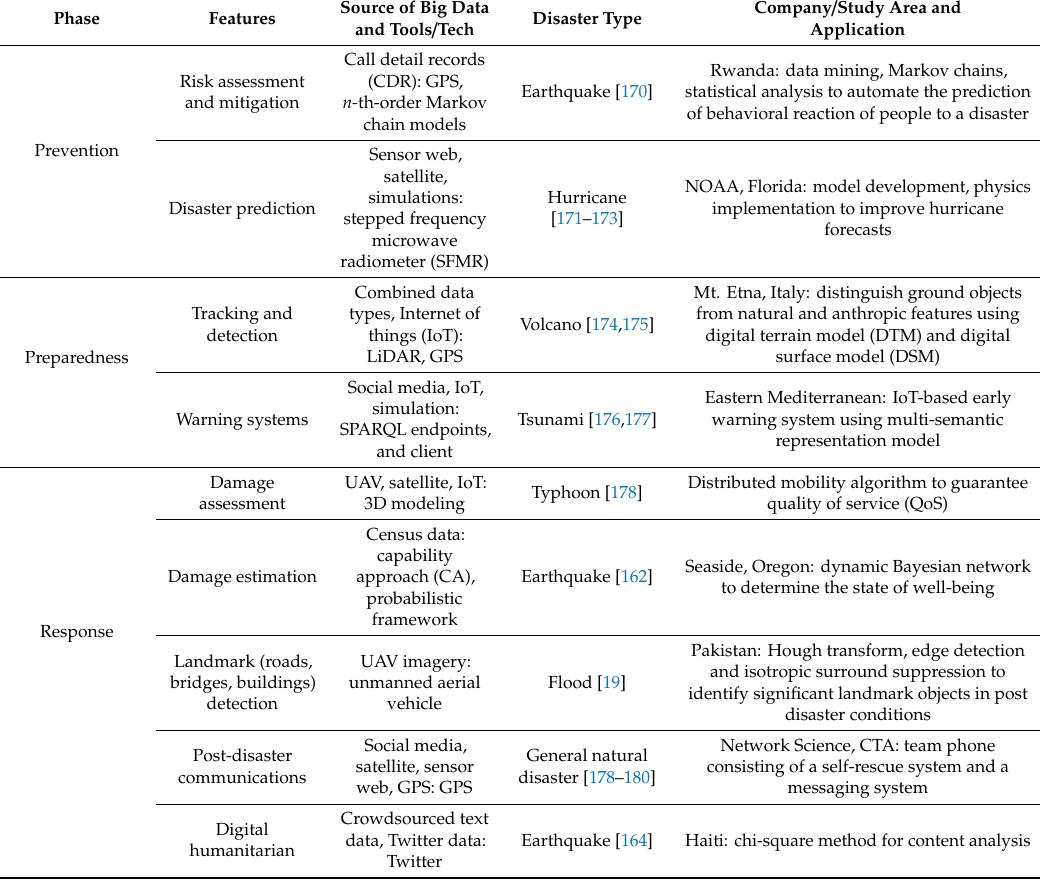
Table 16. Big data sources, features, and phases specific to various disaster